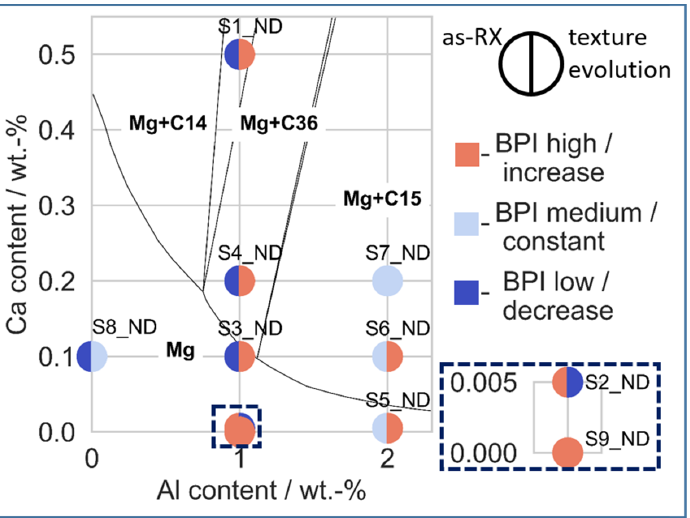
Figure 10. Overview of the as-RX basal peak intensities (BPI) and their evolution during cold rolling for the S_ND samples depicted in the Mg-rich corner of the Mg-Al-Ca phase diagram adapted from [27].